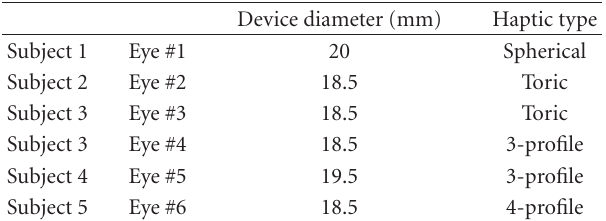
Table 1: Characteristics of PROSE